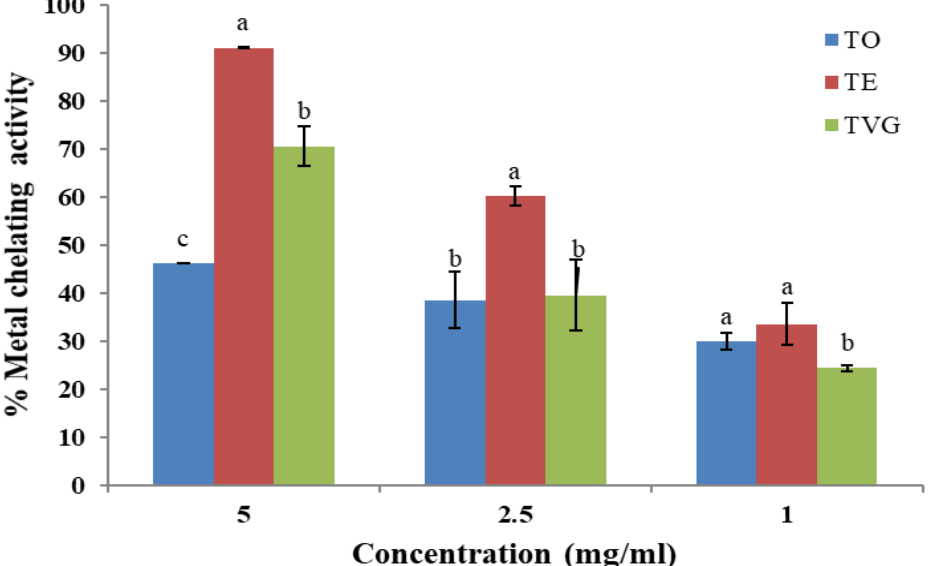
Figure 2. Metal-chelating activity of four different tannin isolates. TO: tannin oenologique; TVG: tannin VR grape; TE: tannin VR supra elegance. Mean ± SD (N = 3). Means with different letters are significantly different ( p < 0.05).